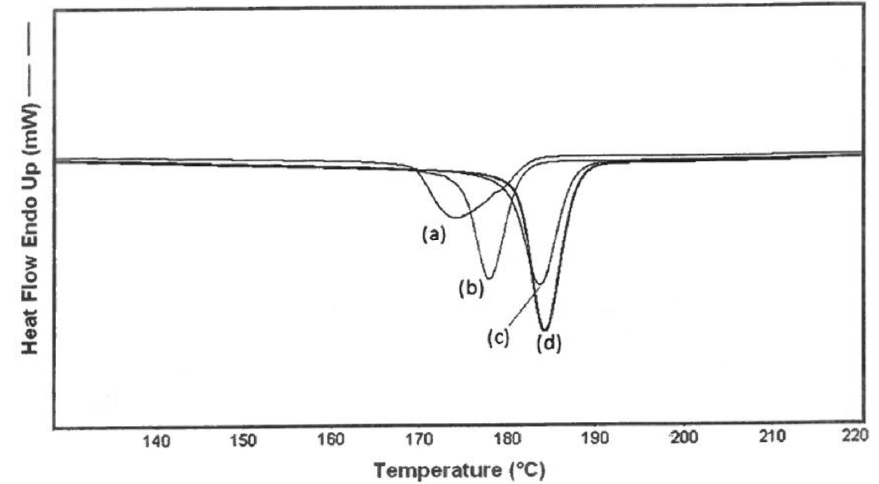
Figure 8. DSC cooling scans (5 °C/min) for neat ( a ) nylon-6 sample (600,000 g/mol) ( b ) nylon-6 with 2